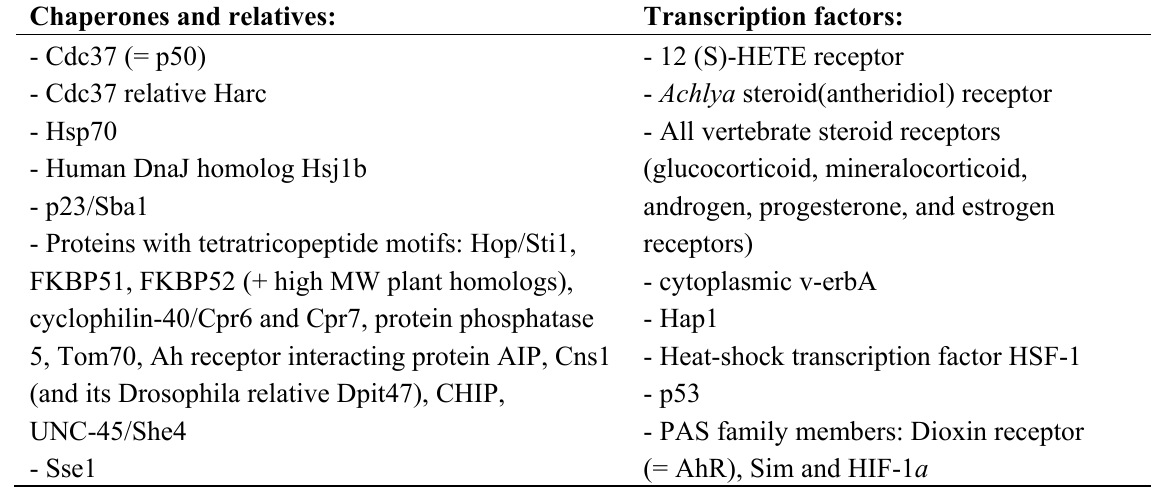
Table 1. Proteins interacting with